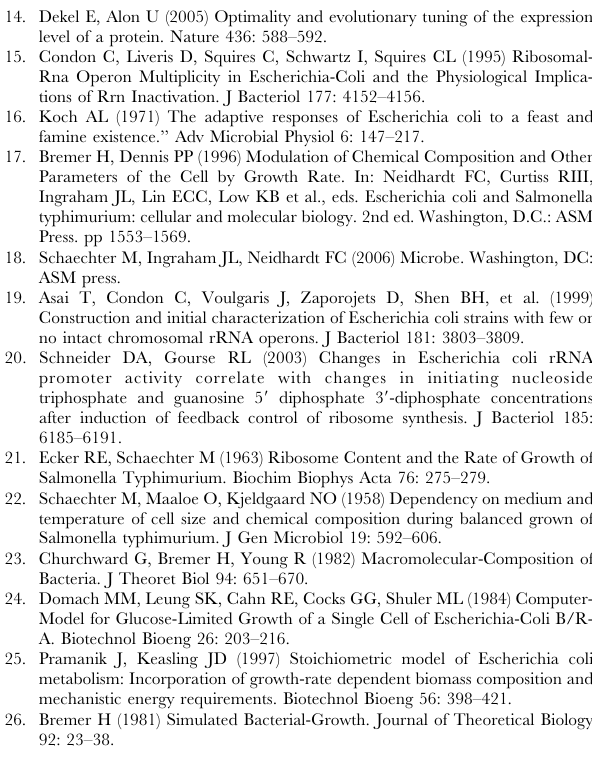
binding affinities. See main text and S1.6 in Text S1 for further explanations. Figure S5 Predictions for bulk protein and ribosome concen- trations as a function of the rrn operon copy number. (A) Total concentration of ribosomes (ribosomes per unit volume) in the constrained and unconstrained CGGR models as a function of the rrn operon copy number. (B) Concentration of bulk protein (proteins per unit volume) in the constrained and unconstrained CGGR models as a function of the rrn operon copy number. Solid lines are for fixed rrn chain elongation rate, c rrn = const, and dashed lines are for c rrn ? const, as described in the main text. All curves are normalized to WT cell state values (at copy number = 7). Figure S6 Breakdown of the ribosome synthesis equation to components for the diffusion limited scenario. (A) Variables in units of concentration. d rrn - rrn gene concentration (total rRNA operon copy number per unit volume); V rrn - rrn initiation rate per operon (init/min/operon); n ribo - ribosome concentration (ribo- somes per unit volume), and m - growth rate. These parameters are tied by Eq. 2iii: a = d rrn ? V rrn /n ribo . (B) Variables in units of molec/ cell. D rrn - rrn gene dosage (total rRNA operon copy number per cell); N ribo - number of ribosomes per cell. These parameters are tied by Eq. 2iii: a = D rrn ? V rrn /N ribo . This simulation is for the diffusion limited scenario assuming that the rRNA chain elongation rate, c rrn , is variable, as described in the main text. All curves are normalized to WT cell state values (at copy number = 7). Figure S7 Gene dosage and gene concentration as a function of growth rate. (A) Gene dosage and (B) gene concentration for the